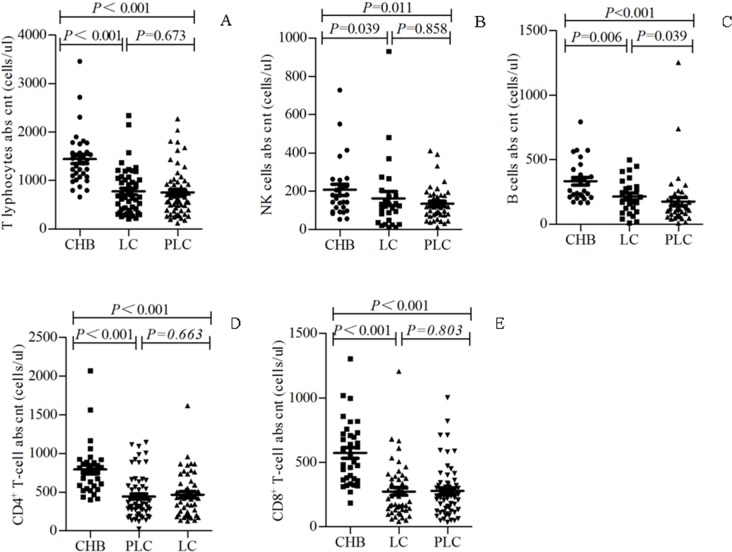
Decreased peripheral lymphocyte subpopulations in patients with HBV-PLC.The concentrations of the peripheral blood T lymphocytes (A), NK cells (B), B cells (C), CD4+ T cells (D), CD8+ T cells (E) were compared between patients with CHB, those with HBV-LC and those with HBV-PLC. p<0.05 was considered statistically significant. abs cnt: absolute count.